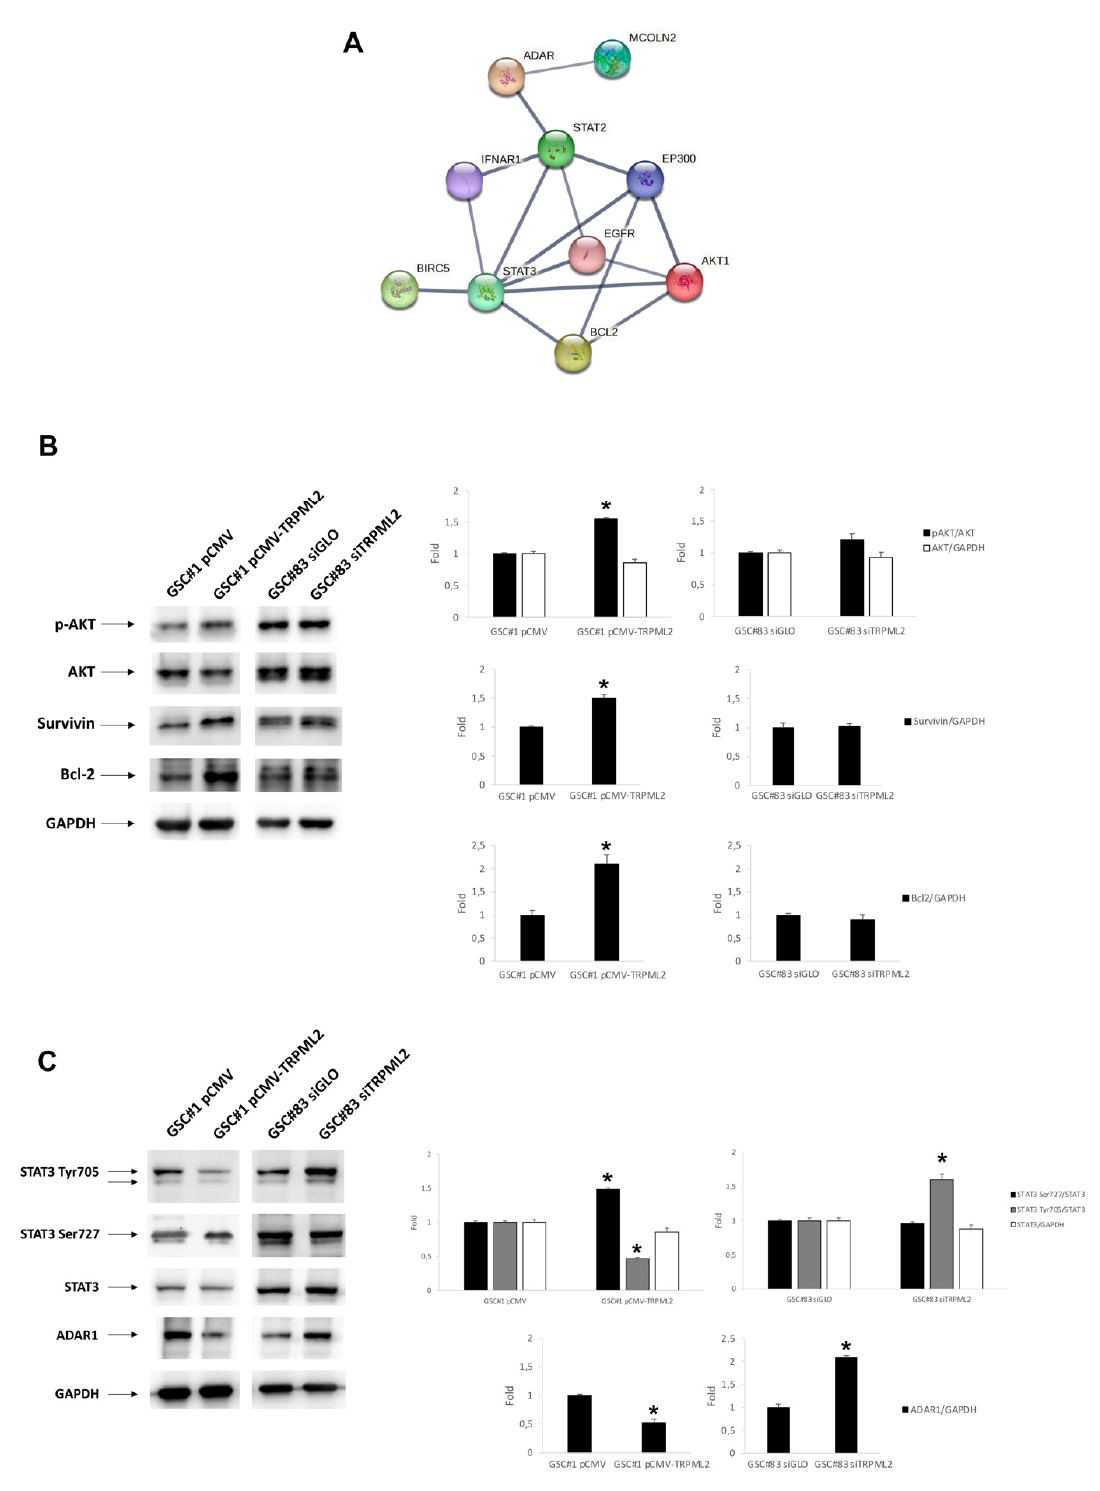
Figure 4. Key candidate proteins in TMZ resistance related to TRPML2 expression. ( A ) The protein– protein interaction network derived from STRING connects the selected markers (PPI enrichment, p value = 0.01). ( B ) Total cell lysates were subjected to western blot analysis to detect the expression